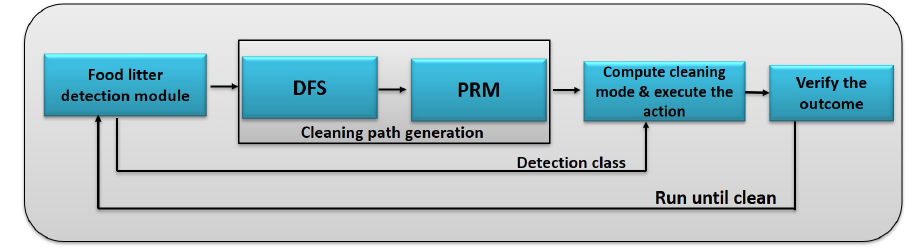
Figure 3. Planner process flow diagram.